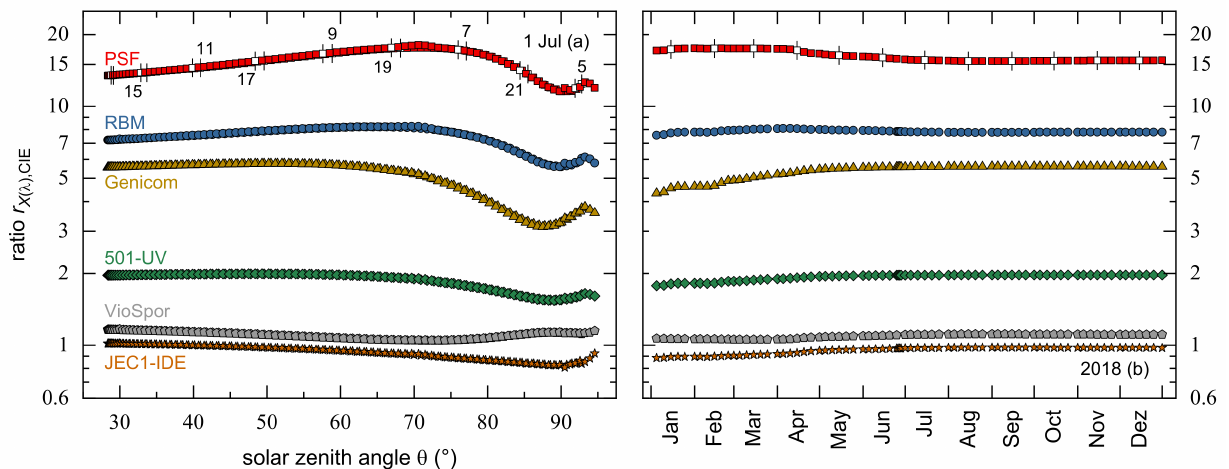
Figure 5. ( a ) Semi-logarithmic presentation of the ratios of measured irradiances, E X ( λ ) , from several detecting systems with regard to those weighted with the CIE standard erythema curve, E CIE , for 1 July 2018. ( b ) Ratios of the daily UV doses for the same detectors as presented in panel ( a ) but depicted as a function of days j (cid:48) in the course of the year 2018. White symbols highlighted with vertical dashes mark ( a ) local daytime and ( b ) the 15th of each